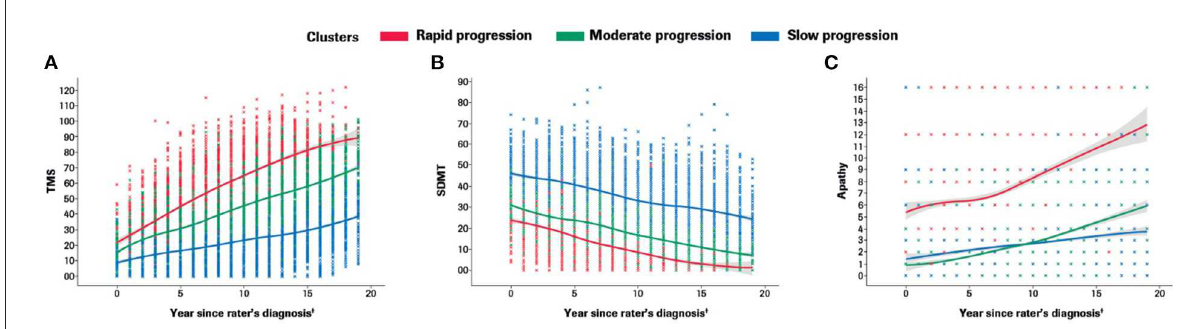
FIGURE2 Marginal plots to demonstrate rapid, moderate and slow disease progression trajectories in the motor (A) , cognitive (B) and behavioral (C) domains included in the multidimensional progression model*. *Marginal 2D plots are shown to visualize the longitudinal progression for each endpoint separately; however, a multidimensional approach was used (km3d) where all three endpoints were jointly modeled. † Symptom onset time ‘0’ defined as the approximate time of first symptom onset (any domain) as determined by the rater using information from multiple sources (e.g., information provided by participant and/or caregiver, medical notes, etc). SDMT, Symbol Digit Modalities Test; TMS, Total Motor Score.